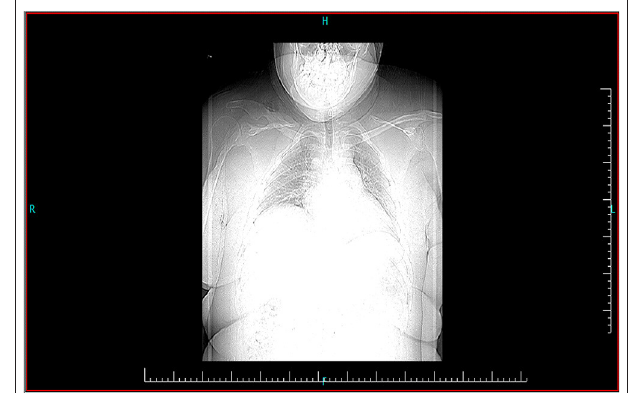
FIGURE 1 | Preoperative computed tomography scan revealing the scope of the lesion. This was essential in identifying the small bone fragments separated from the